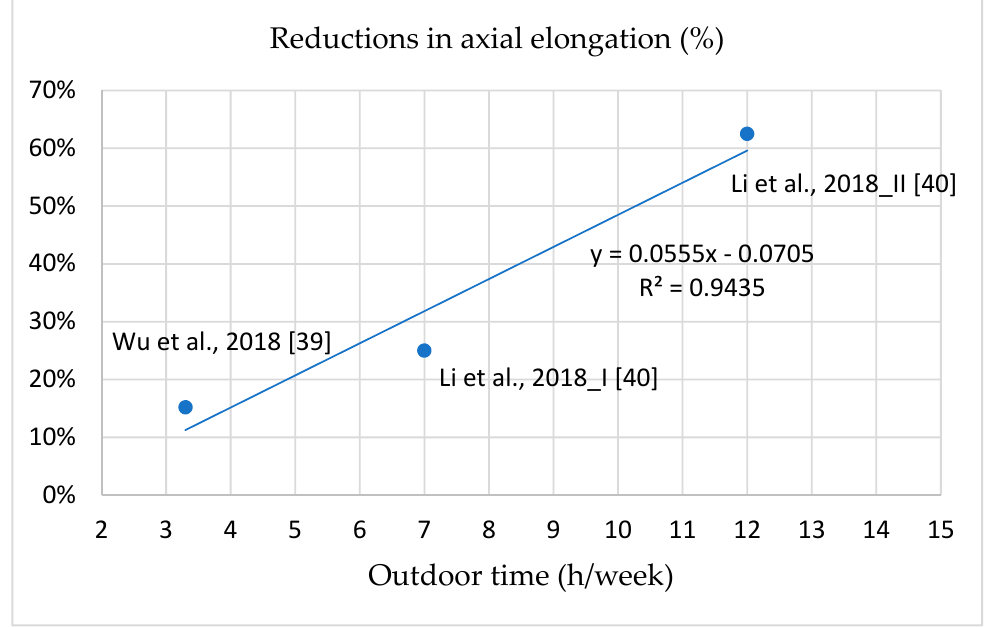
Figure 7. The dose-response effect between reduction ratios in axial elongation and outdoor time at school.